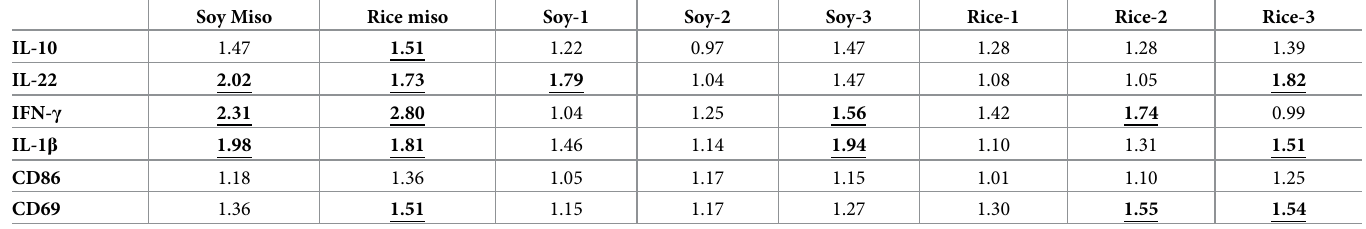
Table 3. Gene expression ratio (sample/control). Soy